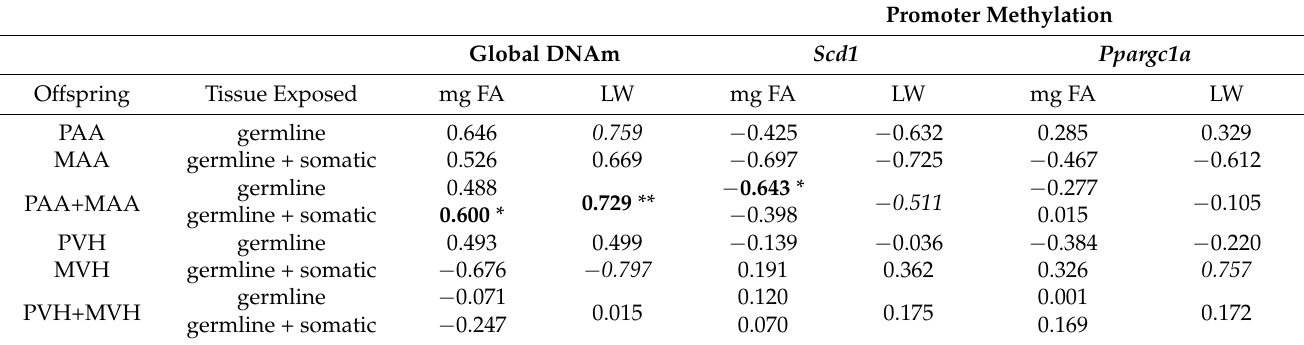
Table 3. Correlations between FA dose or liver weight and global and gene-specific DNA methylation.